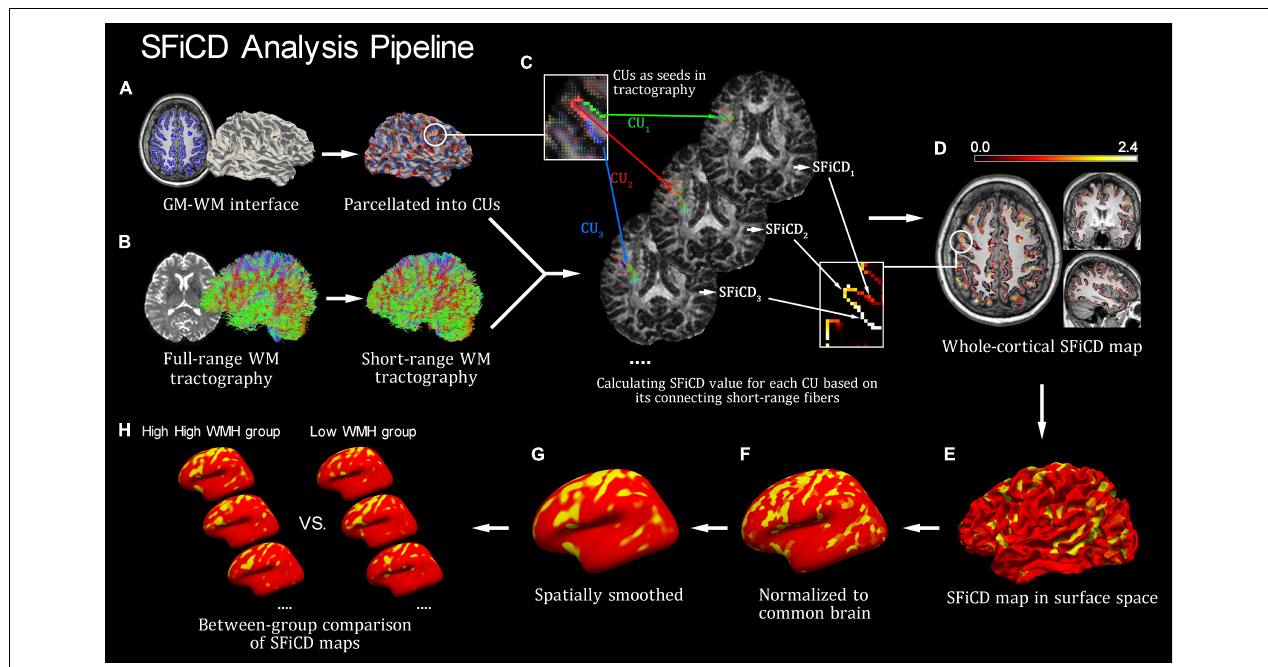
FIGURE 1 | Introduction of the short-range fiber connectivity density (SFiCD) mapping framework. (A) Cortical parcellation and cortical units (CUs). (B) Construction of short-range fiber tractography. (C) Calculation of SFiCD value for each CU. (D) Whole-cortical SFiCD map in volume space. (E) SFiCD map projected to surface space. (F) Spatial normalization of SFiCD map. (G) Spatial smooth of SFiCD map. (H) Group-level vertex-wise statistical analysis of cortical